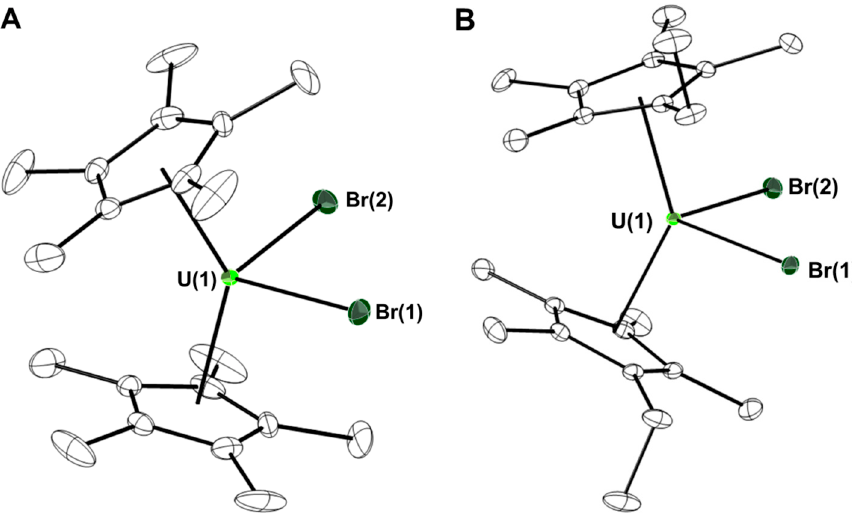
Figure 2. Molecular structure of (C 5 Me 5 ) 2 UBr 2 ( 33 ) ( A ) and (C 5 Me 4 Et) 2 UBr 2 ( 34 ) ( B ) with thermal ellipsoids projected at the 50% probability level. Hydrogen atoms have been omitted for clarity. Selected bond distances (Å) and angles (°) for 33 : U(1)–Br(1), 2.7578(5); U(1)–C Cent , 2.438(4); Br(1)–U(1)–Br(2), 97.64(3); C Cent(1) –U(1)–C Cent(2) , 137.57(15). For 34 : U(1)–Br(1), 2.7609(4); U(1)–Br(2), 2.7607(4); U(1)–C Cent , 2.444(2); Br(1)–U(1)–Br(2), 96.224(14); C Cent(1) –U(1)–C Cent(2) , 138.50(8).